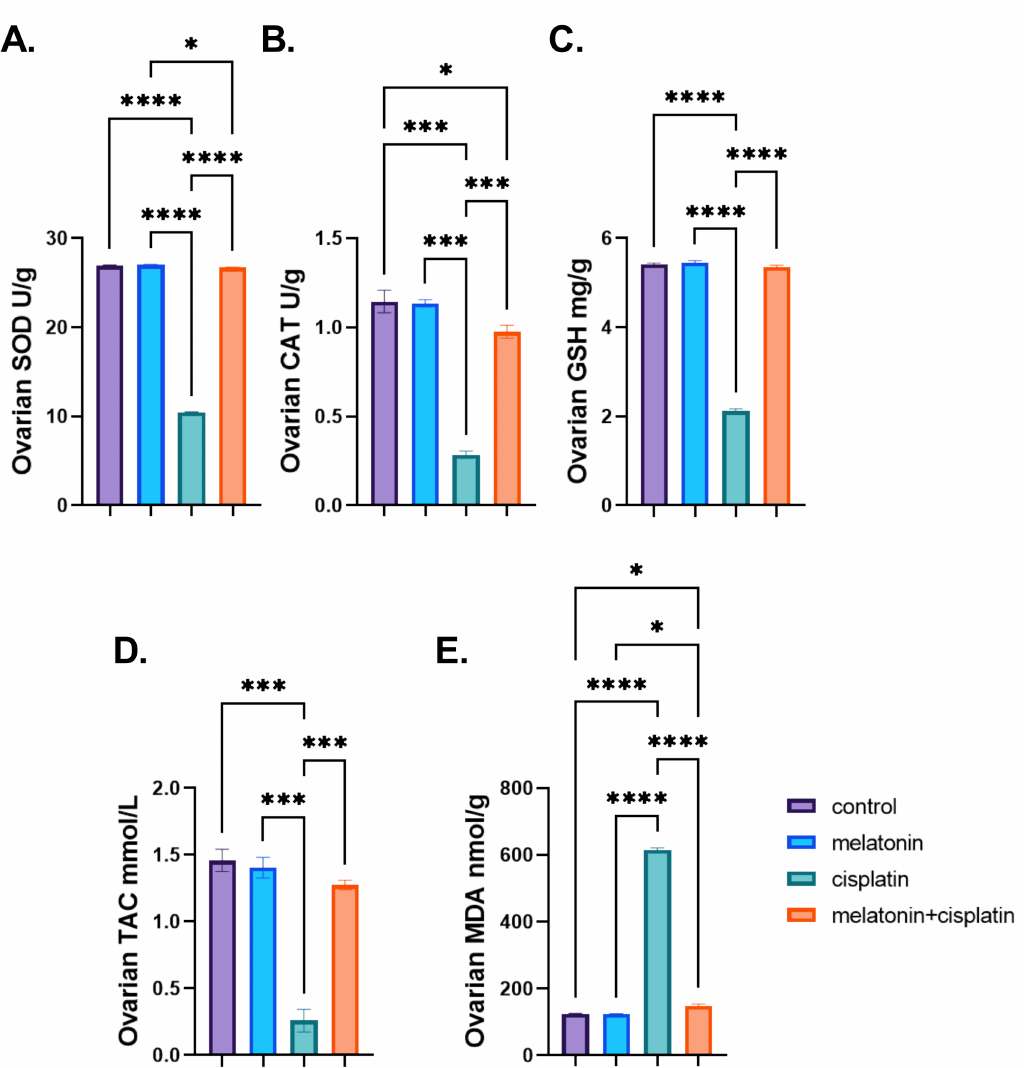
Figure 9. Effect of melatonin administration in cisplatin-induced ovarian impairment in female rats on ovarian oxidative stress biomarkers ( A – E ). ( A ) Ovarian SOD (U/g), ( B ) ovarian CAT (U/g), ( C ) ovarian GSH (mg/g), ( D ) ovarian TAC (mmol/L), and ( E ) ovarian MDA (nmol/g). Data are expressed as means ± SEM. n = 8. *, ***, **** indicate significant difference ( p < 0.05, p < 0.001, and p <